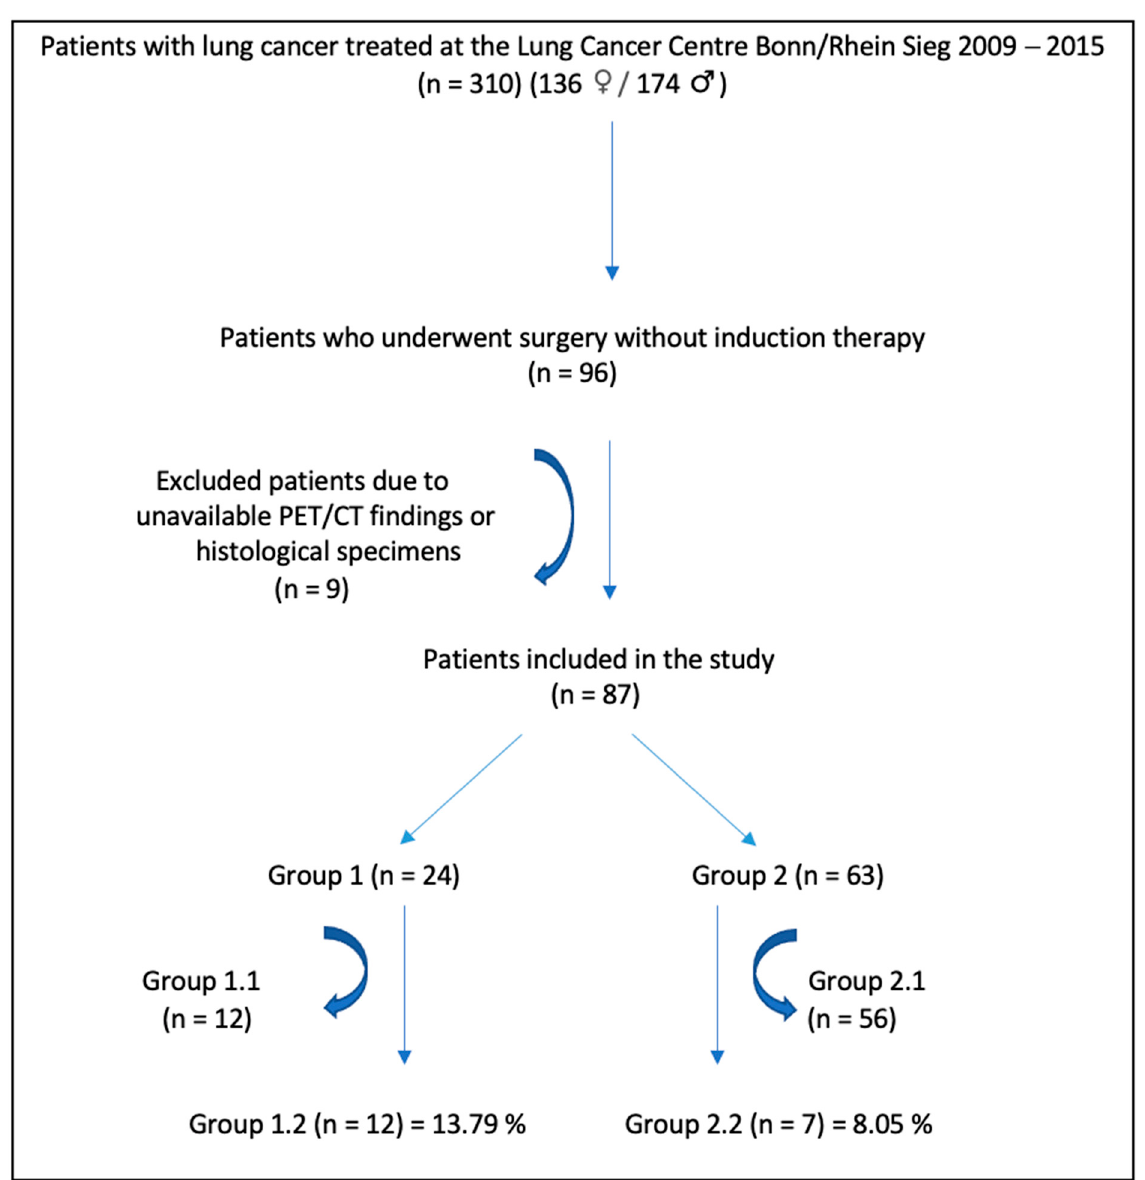
Figure 3. Flow chart for data evaluation. Table 4. Number and size of LNM in group 1.2. Patients in Group